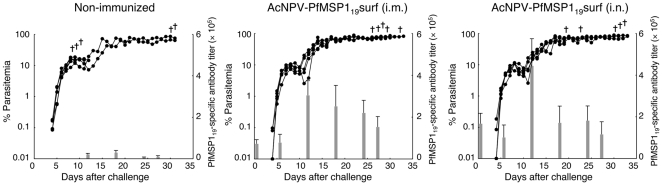
Kinetics of PfMSP119-specific antibody titers and parasitemia during the course of infection.Groups of mice were non-immunized or immunized either i.m. or i.n. with AcNPV-PfMSP119surf, and then challenged i.v. with 103 Pb-PfM19 pRBC. Parasitemia was monitored daily 4 days after challenge and sera were collected periodically post-challenge to measure antibody titers. The bar chart indicates PfMSP119-specific antibody titers on the left vertical axis. The line graph indicates the course of parasitemia (%) on the right vertical axis. (+), death.